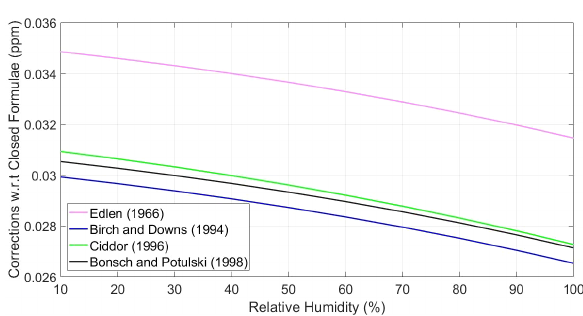
Figure 16. Comparison of EDM corrections in each model w.r.t Closed Formulae model